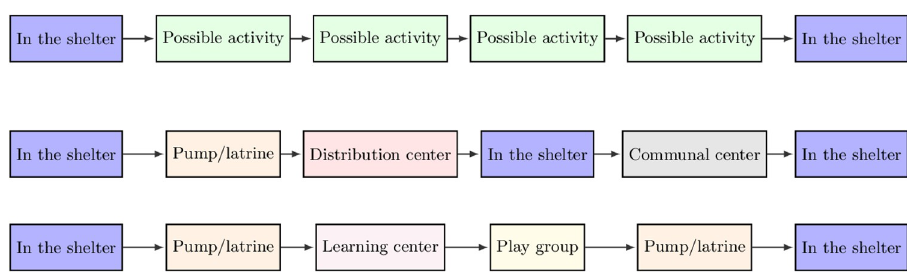
Fig 2. Top: Daily routine structure for individuals modeled in the simulation. We allow each individual to perform up to four possible activities per day (although this can be flexibly changed). If an activity is not chosen, the individual returns to their shelter. Middle: Example of a simulated day for an adult in the settlement. Bottom: Example of a simulated day for a child attending a learning center in the settlement.